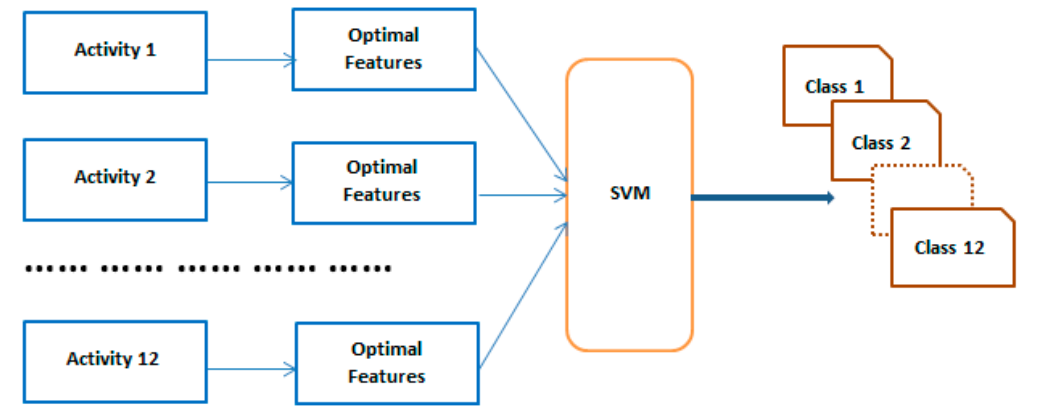
Figure 6. Overall block diagram of the validation process.